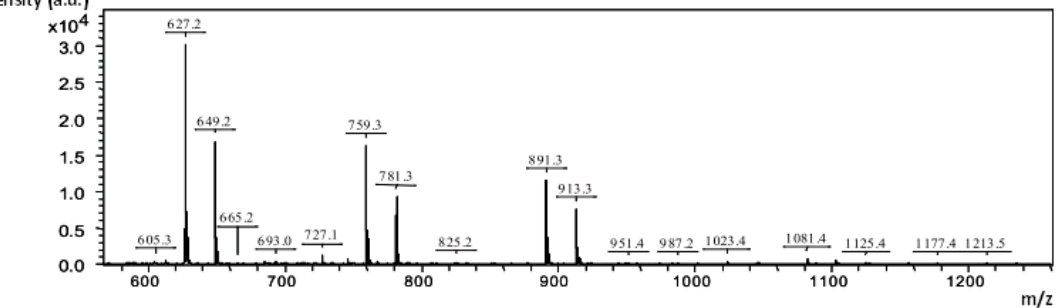
Figure 2. Mass spectrum from positive-mode MALDI-TOF MS for the FI KOH hemicellulosic fraction (1 mg · mL − 1 ) generated by hydrolysis with endo-xylanase.